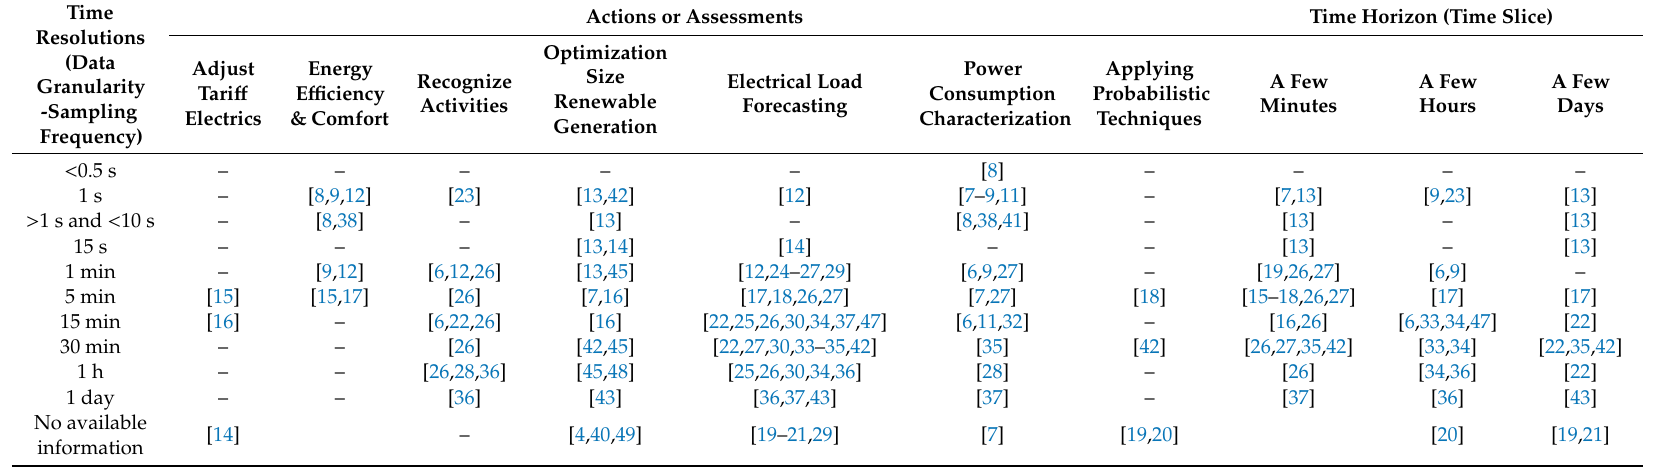
Table 1. Literature published related to load profiles in